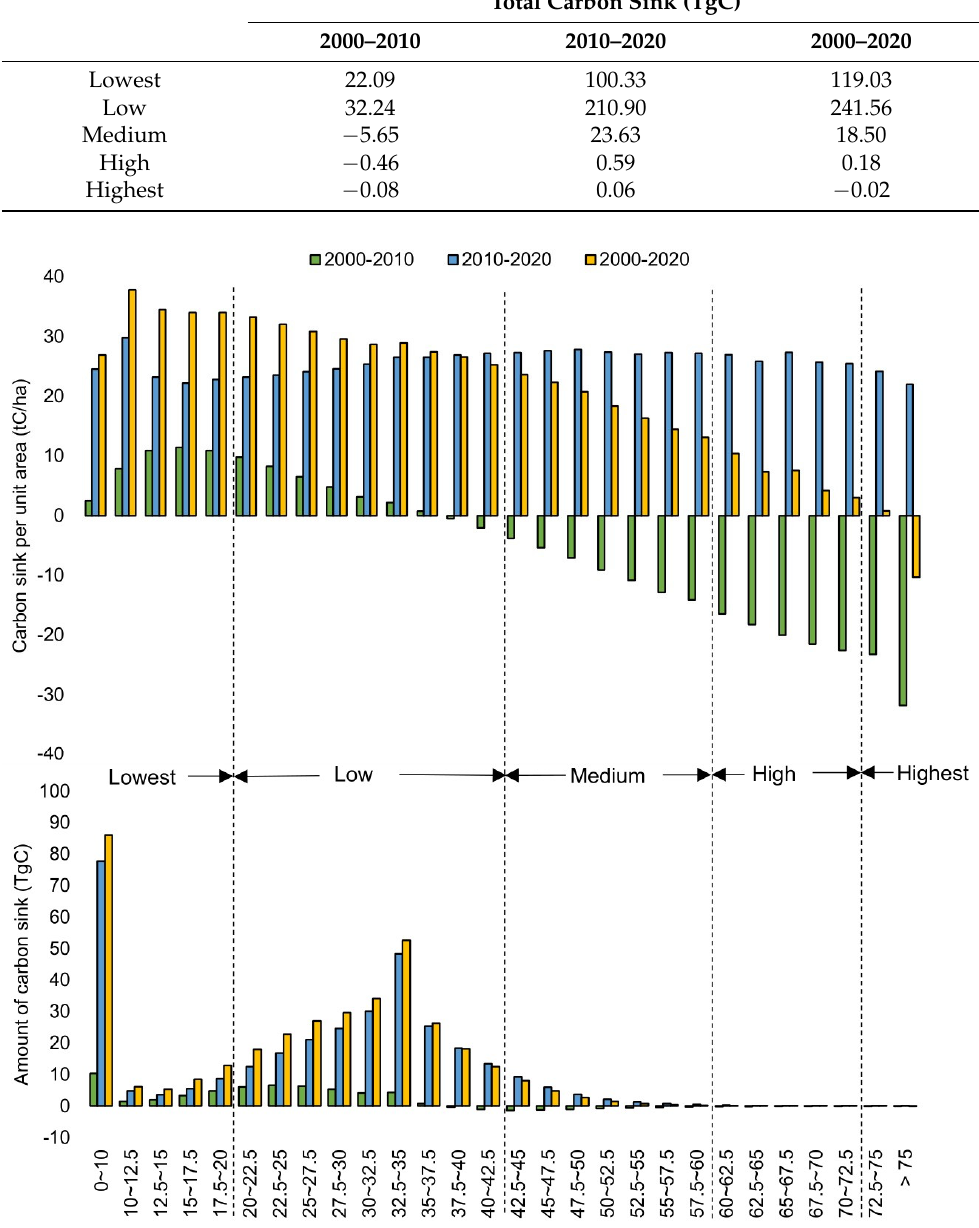
Figure 9. Carbon sinks contributed by different initial carbon densities from 2000 to 2020.